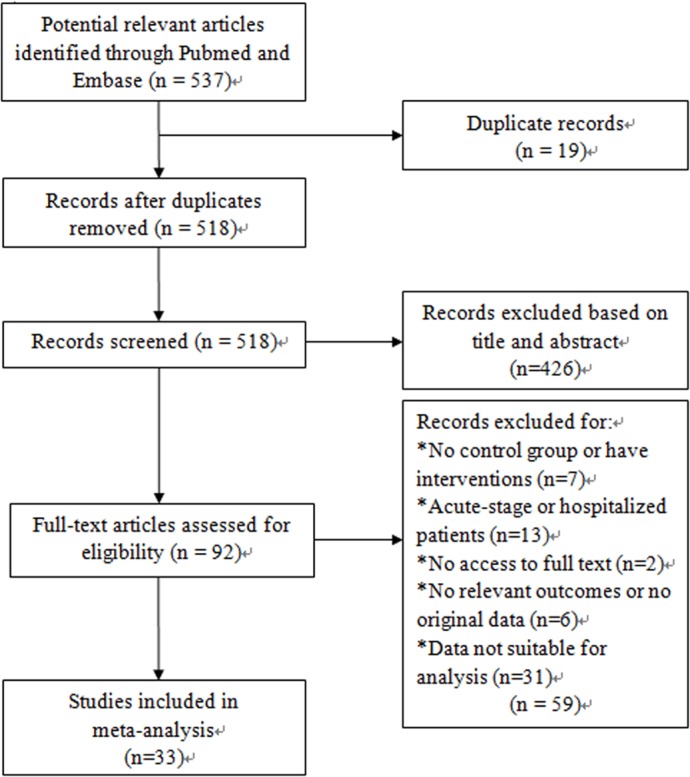
Flow diagram of study indentification, inclusion and exclusion.